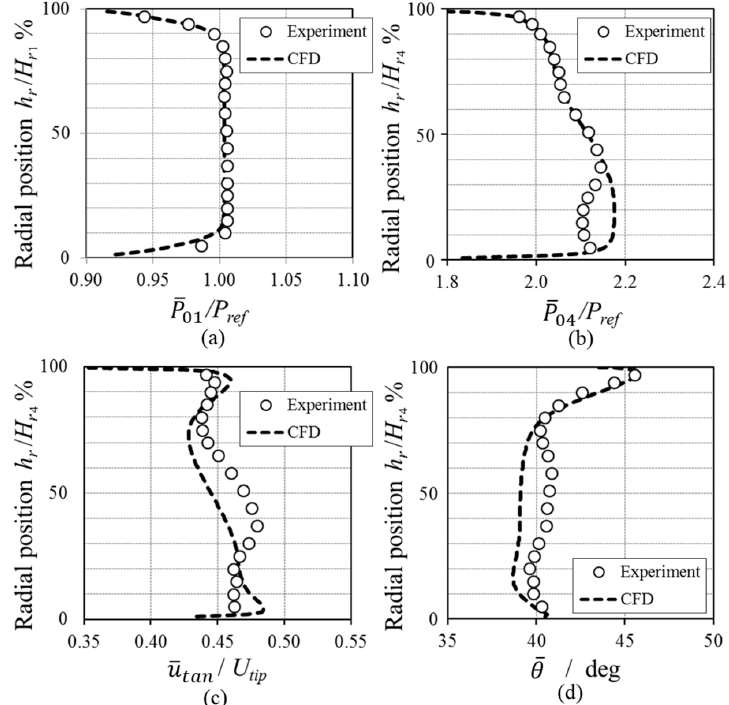
Figure 7. Circumferentially mass-averaged radial profiles at Station 4 of Figure 4. Comparison between CFD and experimental data reported in [26,27]. ( a ) Normalized total pressure at Station 1; ( b ) normalized total pressure at Station 4; ( c ) normalized tangential velocity at Station 4; ( d ) flow angle at Station 4.